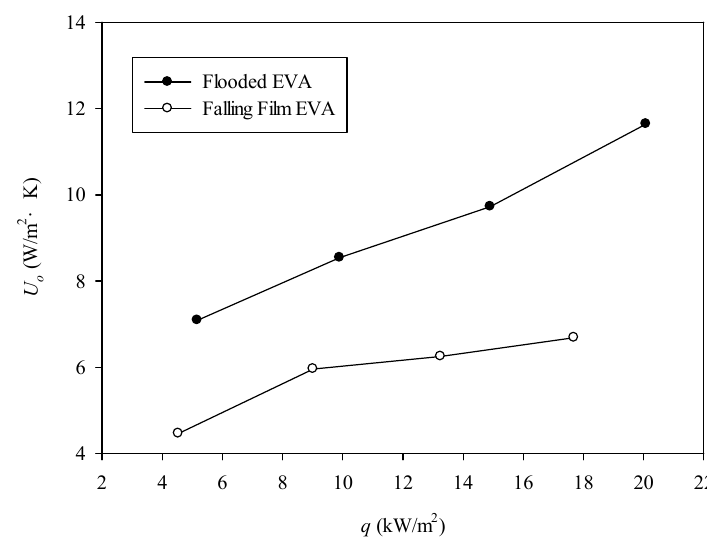
Figure 3. The overall heat transfer coefficient U vs. heat flux for the falling film evaporator and the flooded evaporator.